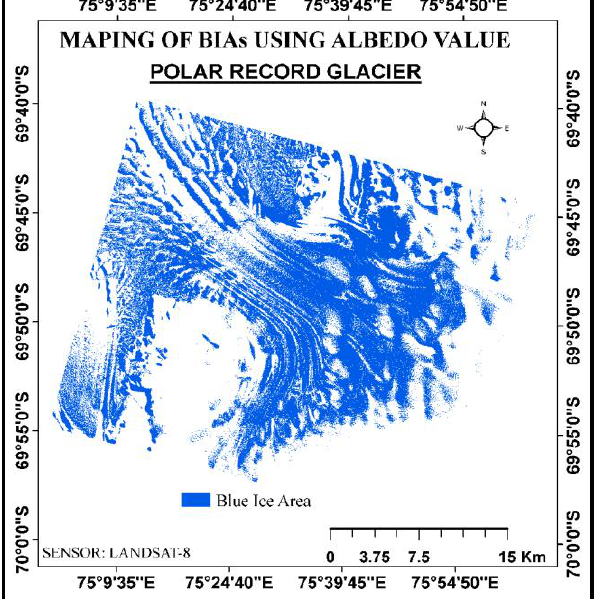
Figure 2: BIAs derived from albedo using Landsat-8 Imagery